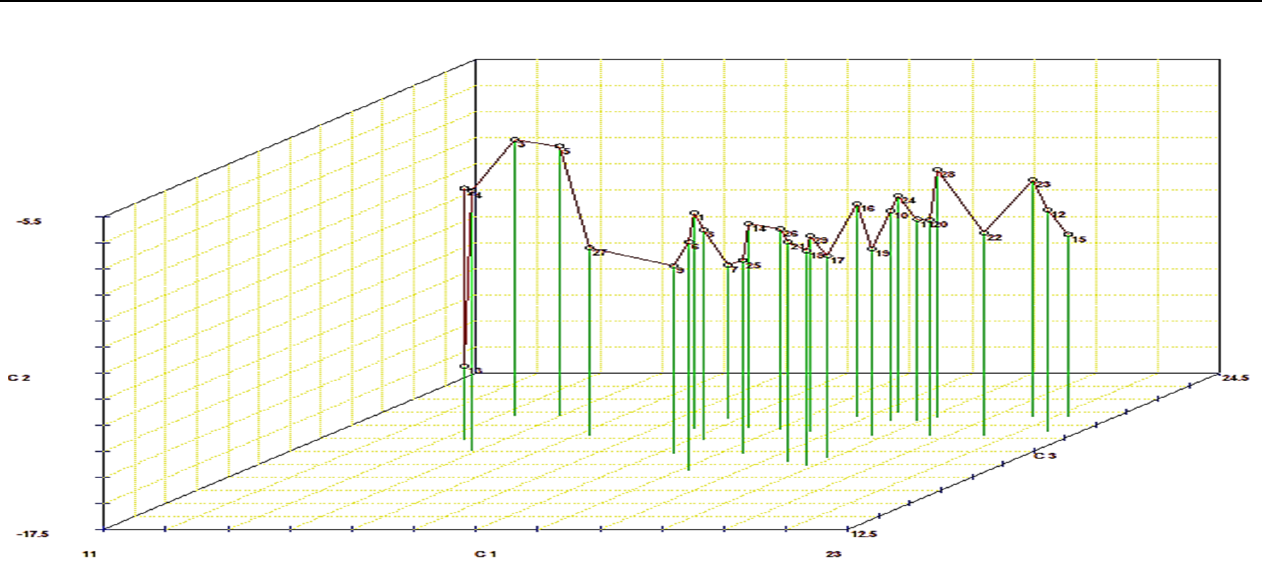
Figure 3. Three-dimensional scheme of yield potential (YP), yield stress (YS), and yield index (YI) for 29 rice genotypes; C1, C2, and C3 are the first, second, and third principal components, respec- tively.